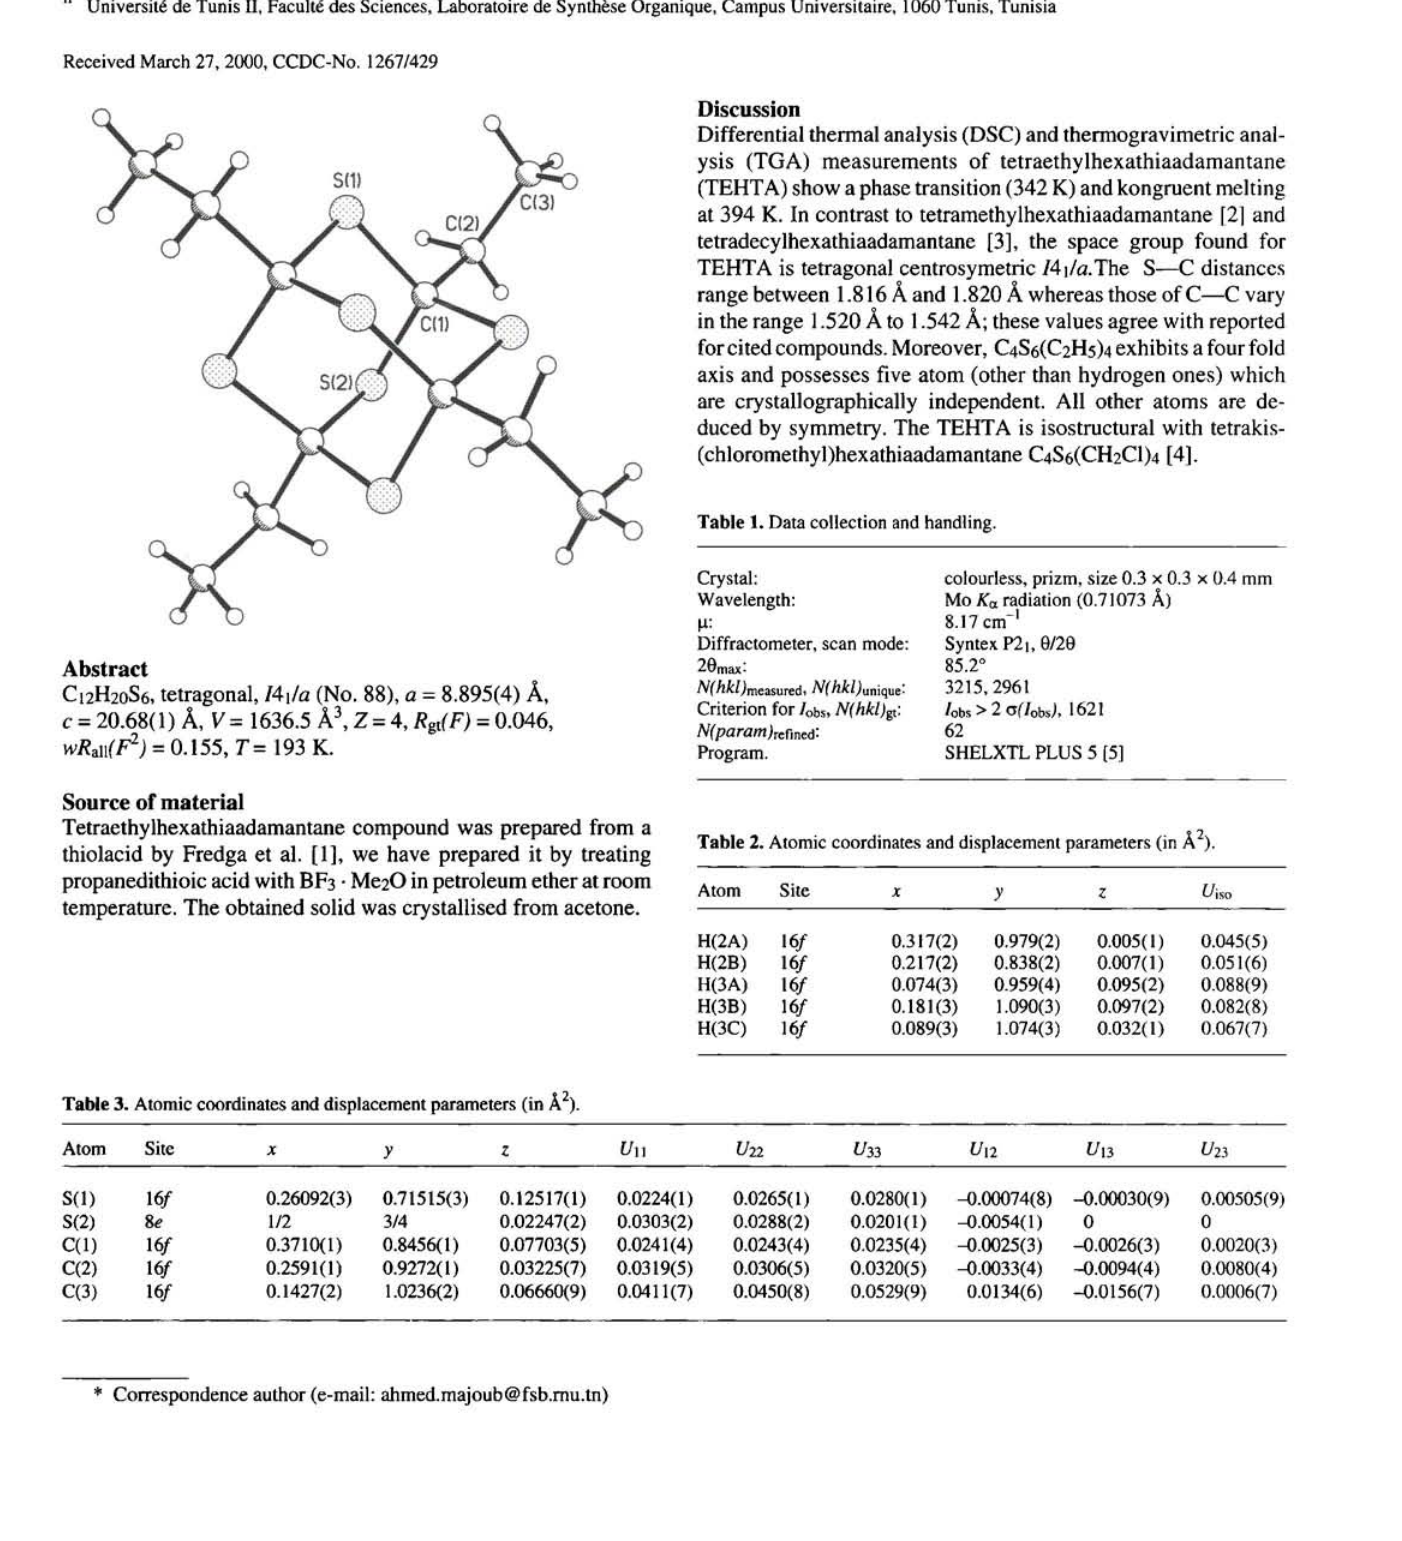
Table 2. Atomic coordinates and displacement parameters (in Â 2 ).